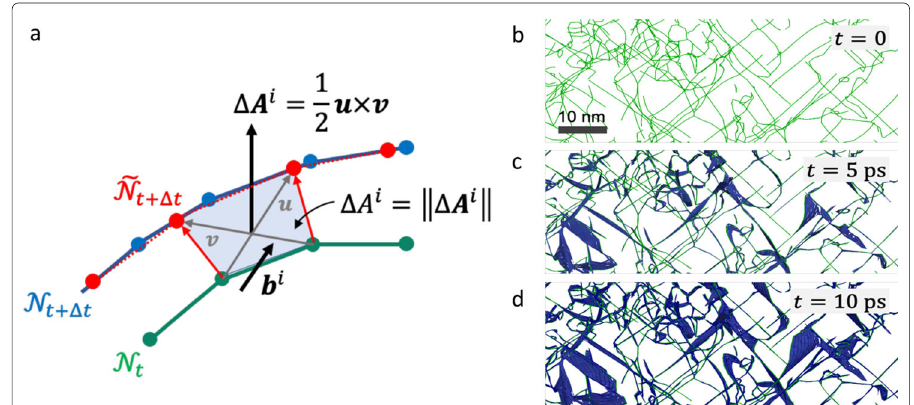
Fig. 1 a Schematic of a unit slip facet ((cid:2) A i , b i ) (shaded quadrilateral) extracted with the STA algorithm by reconnecting networks N t (green nodes and segments) and N t + (cid:2) t (blue nodes and segments) through approximant ˜ N t + (cid:2) t (red nodes and dashed red segments). The magnitude (cid:2) A i = (cid:3) (cid:2) A i (cid:3) of the normal vector is equal to the area swept by the segment over the same time interval (cid:2) t . ( b – d ) Dislocation motion in the form of slip facets extracted using the STA algorithm from an MD simulation of metal plasticity in bcc Ta. b The green lines show dislocation positions at time t = 0. The blue surfaces are composed of slip facets reconnecting positions of the same dislocations at c t = 5ps and d t =